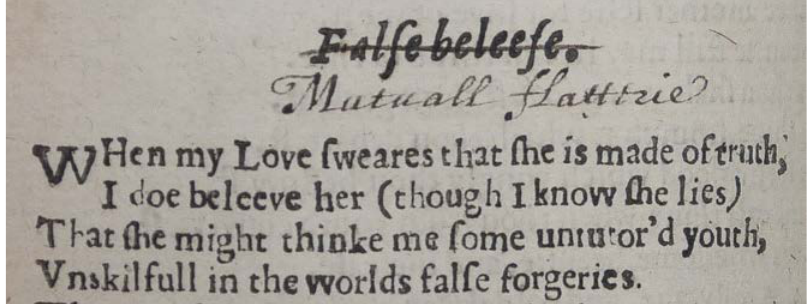
Fig. 2 – Folger STC 22344 Copy 2, sig. B1v